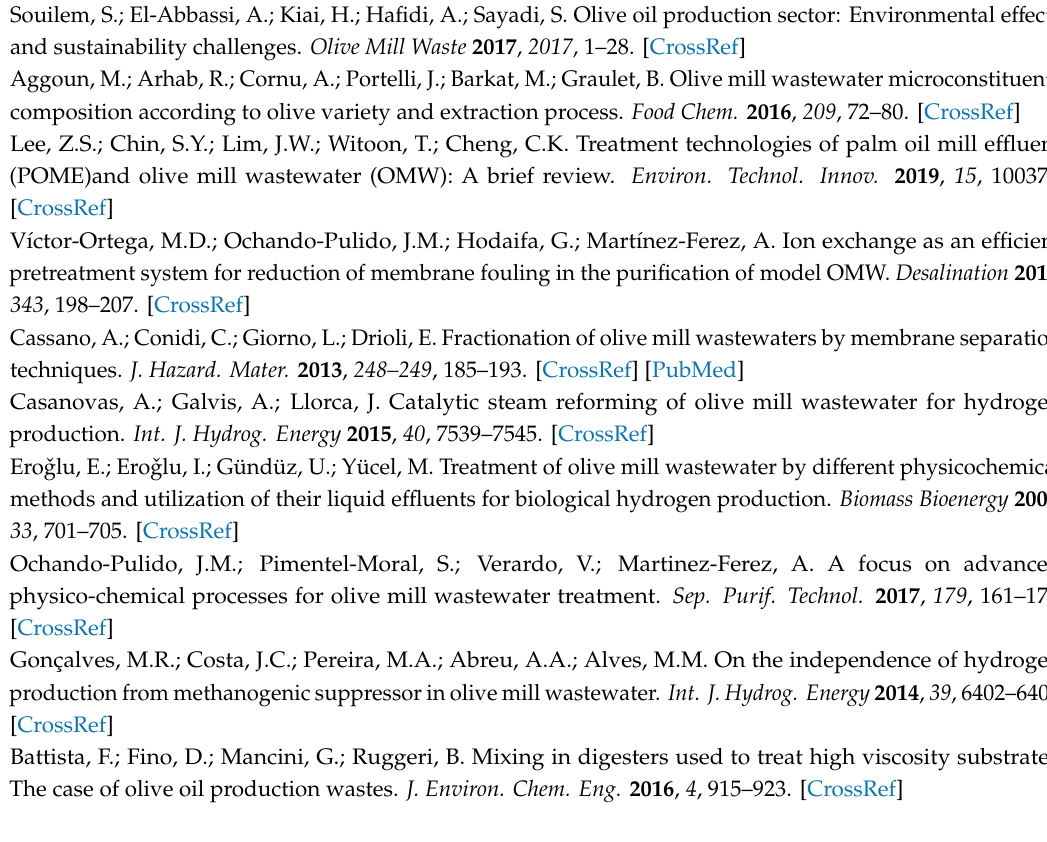
Table S1: Characterization of initial OMW samples, and Table S2: Characterization of residue samples obtained in reforming